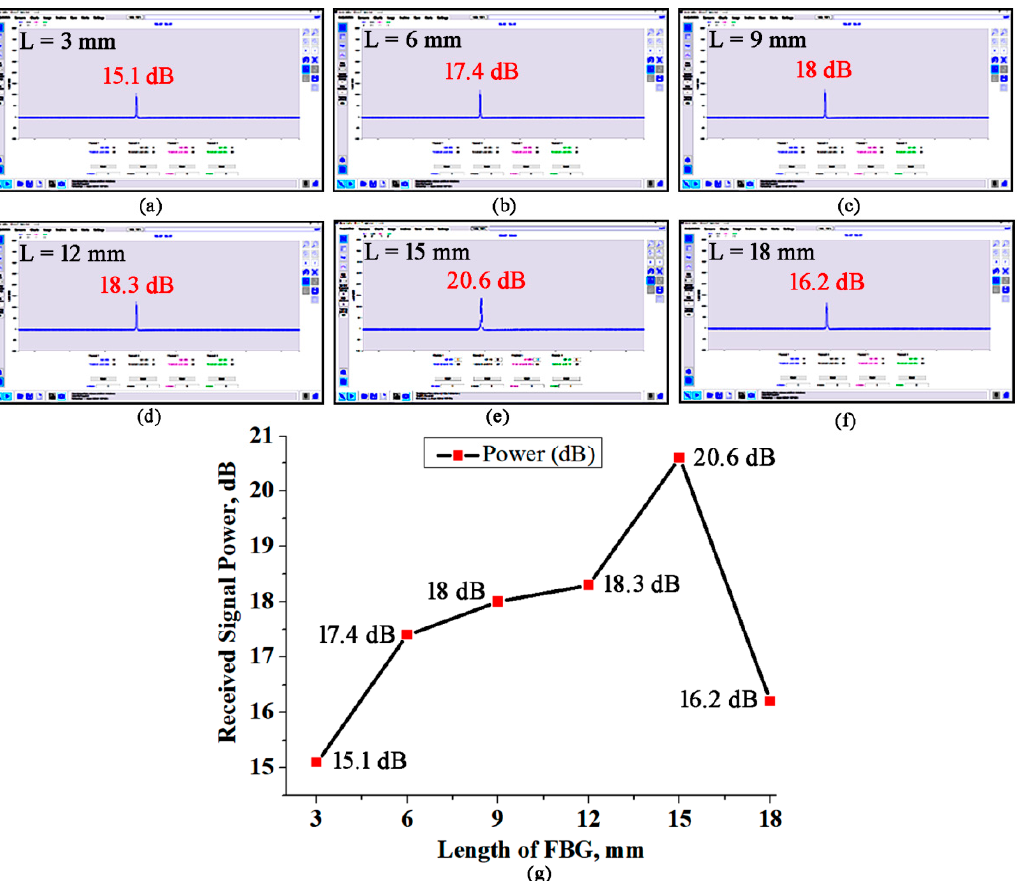
Figure 8. Interrogator-assisted measurement of the received signal power (at λ B = 1542 nm) reflected back from FBGs of different lengths (L) fabricated by irradiating a femtosecond laser beam with a power of 350 mW for 15 s. ( a ) L = 3 mm; ( b ) L = 6 mm; ( c ) L = 9 mm; ( d ) L = 12 mm; ( e ) L = 15 mm; ( f ) L = 18 mm; ( g ) dependence of the received signal power on the length of the FBGs. For a FBG with a length of 6 mm, we measured a signal peak of 17.4 dB, as shown in